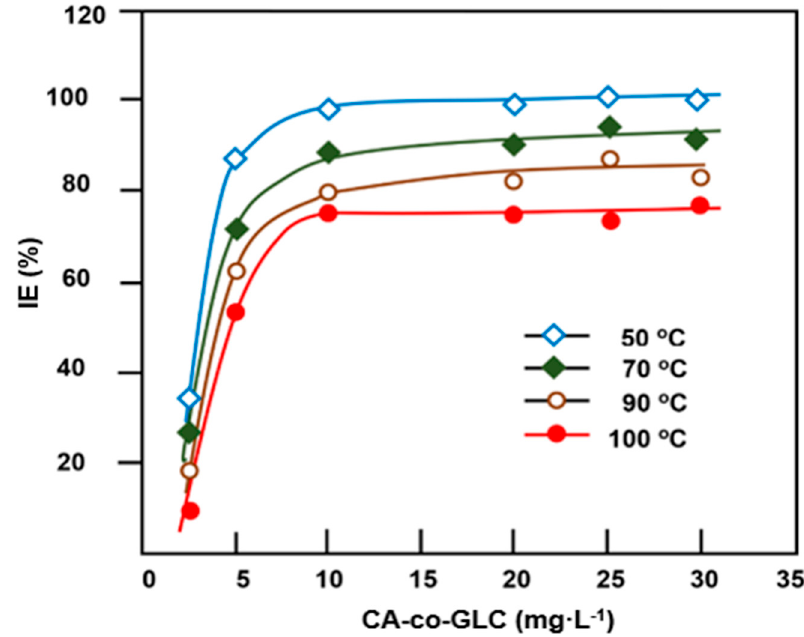
Figure 4. Variation in the scale inhibition efficiency (IE) versus the concentration of CA-co- GLC at a media pH of 7.5 and with 1000 mg·L − 1 Ca 2+ .